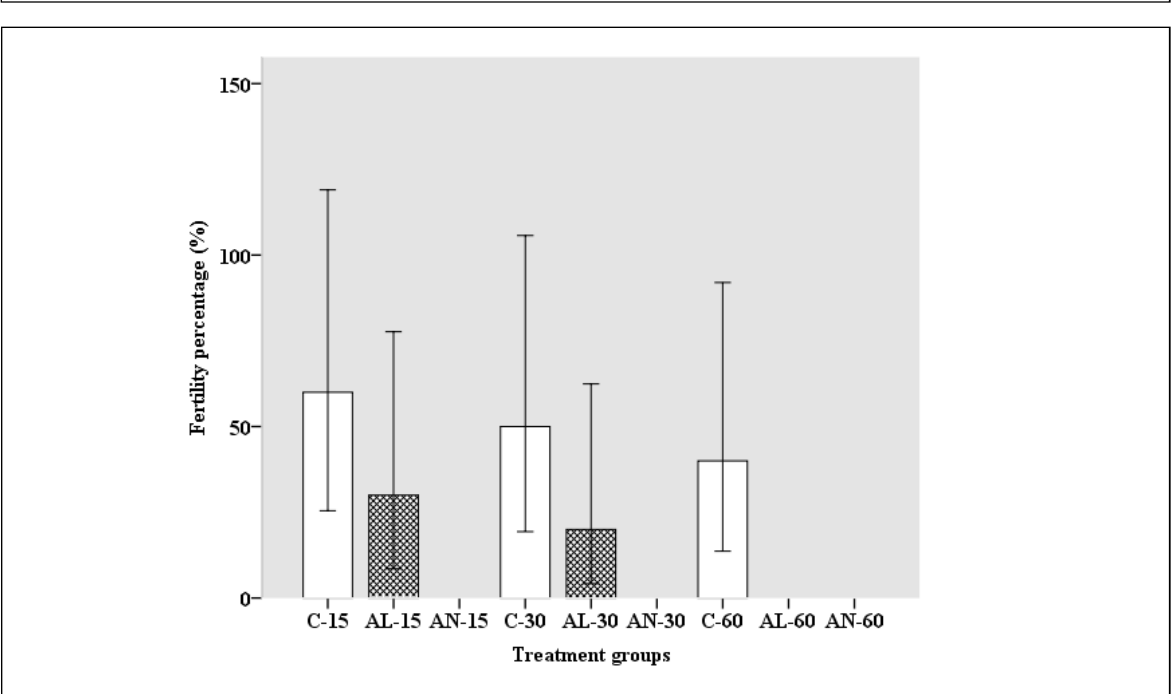
Figure 1: Effect of crude plant extracts in feed on fertility success rate (fertility percentage) following its treatment for 15, 30, or 60 days in the M. natalensis male rats. C = control groups, AL= A. lebbeck stem bark methanolic extracts, AN = A. nilotica pods methanolic